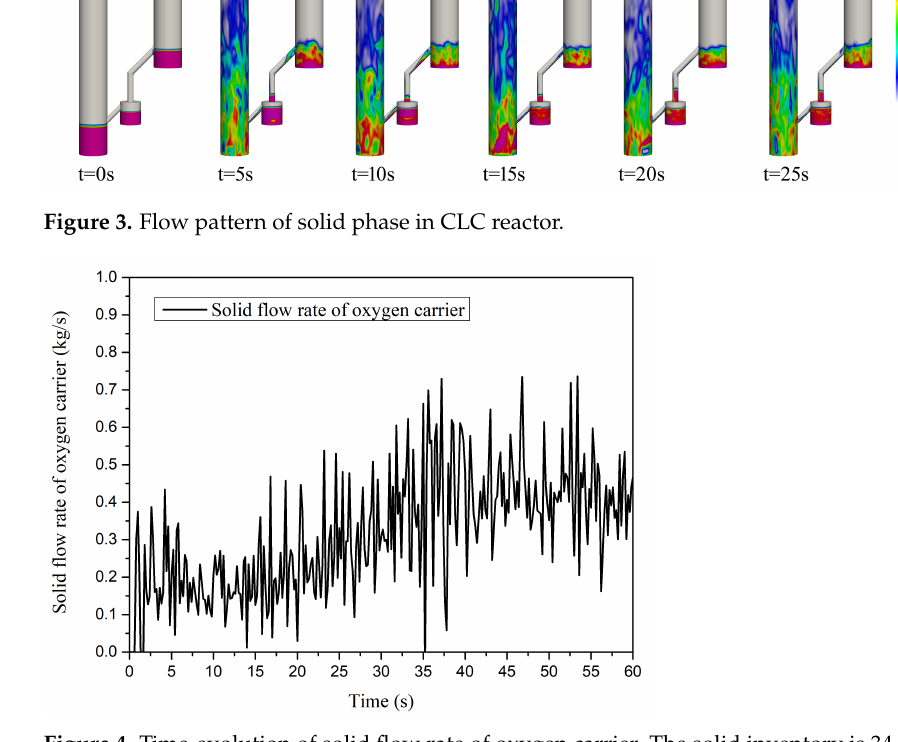
Figure 4. Time-evolution of solid flow rate of oxygen carrier. The solid inventory is 34.6 kg.